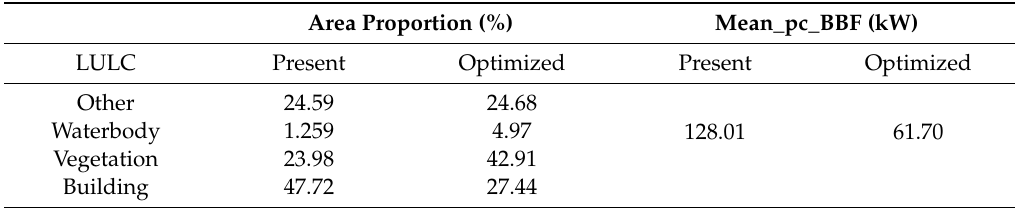
Table 4. Changes in summertime Mean_pc_BBFs associated with present and optimized parcel-level LULC